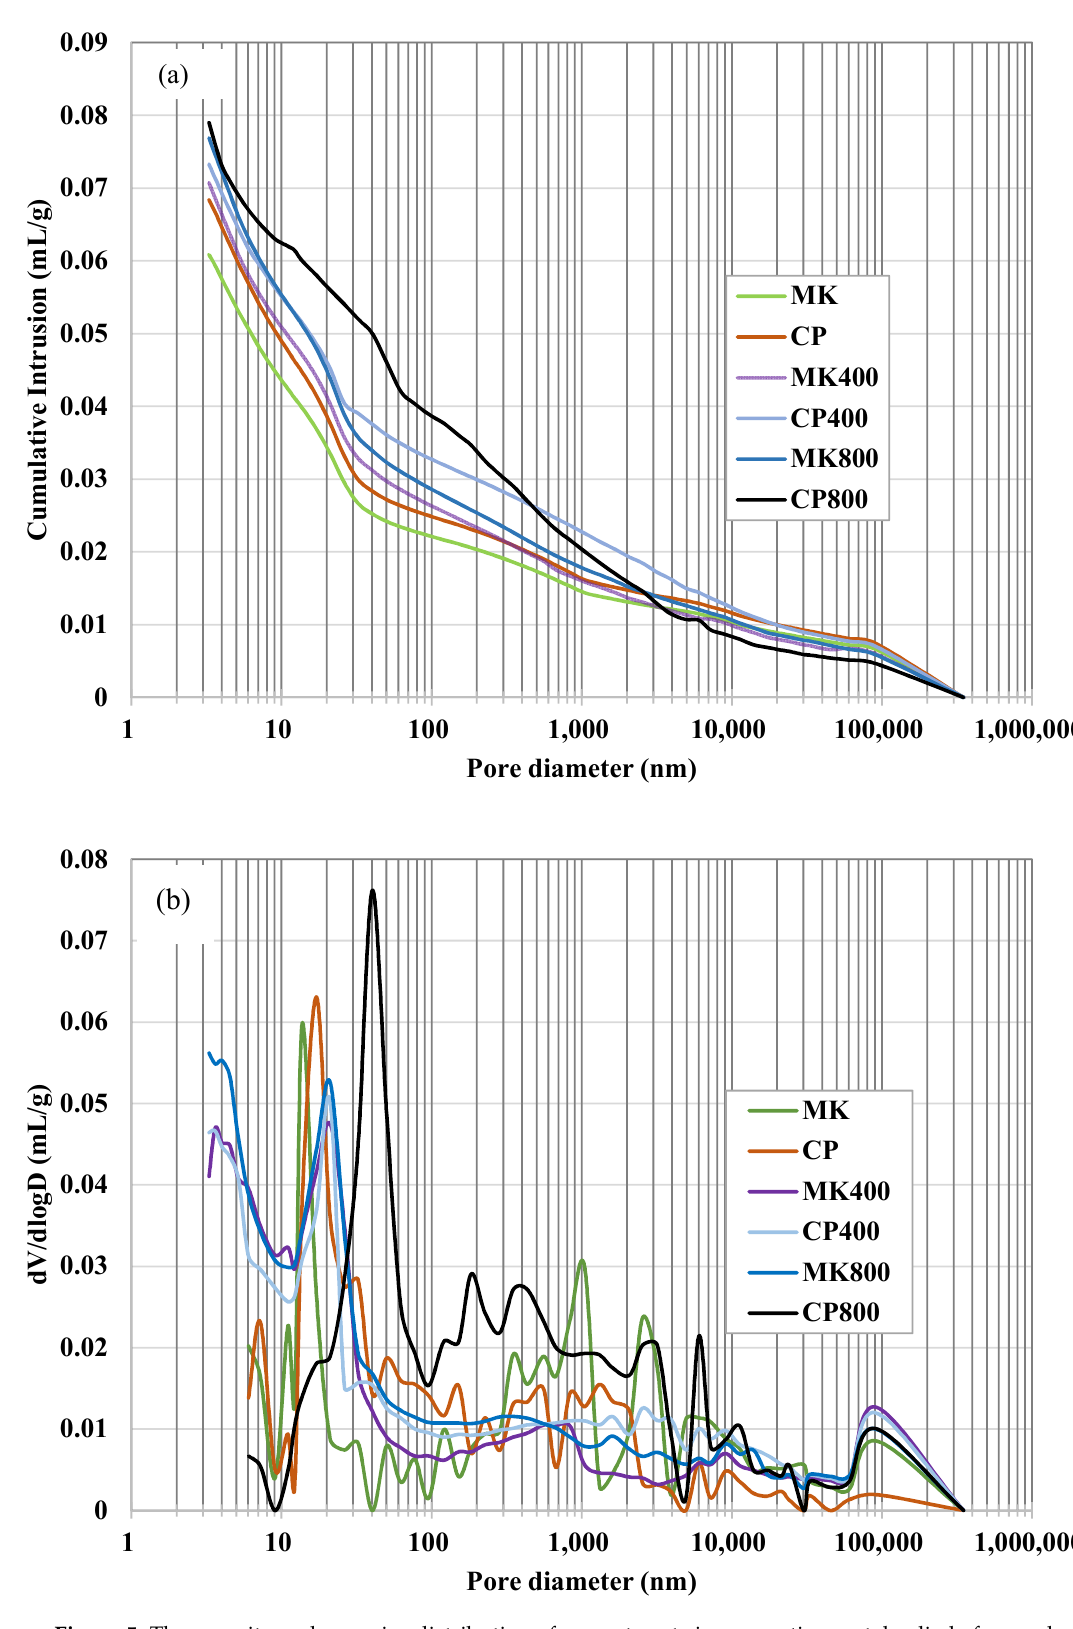
Figure 5. The porosity and pore size distribution of cement paste incorporating metakaolin before and after high-temperature exposure. ( a ) Cumulative intrusion; ( b ) incremental intrusion.